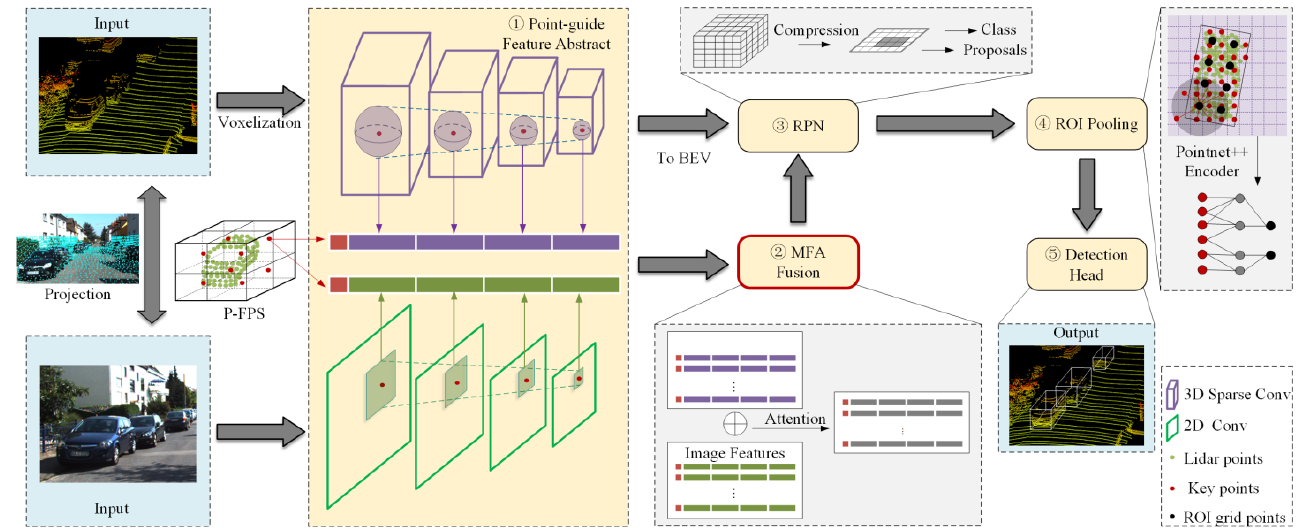
Figure 1. The architecture of the proposed 3D object detection.